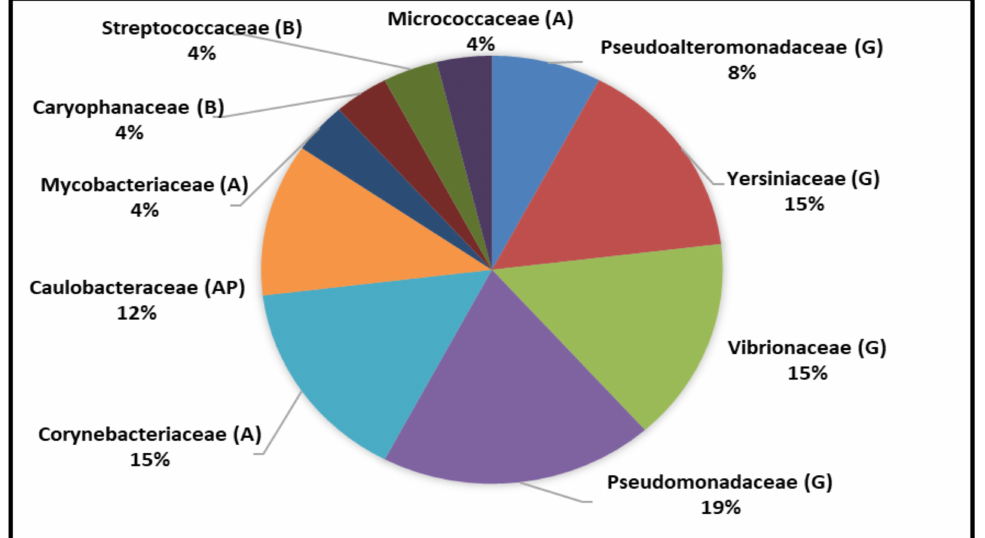
Figure 5. Proportion of bacterial isolates in coral ( S. pistillata ) mucus based on a biochemical approach (A: Actinomycetia; B: Bacilli; AP: Alphaproteobacteria; C: Cytophagia; G: